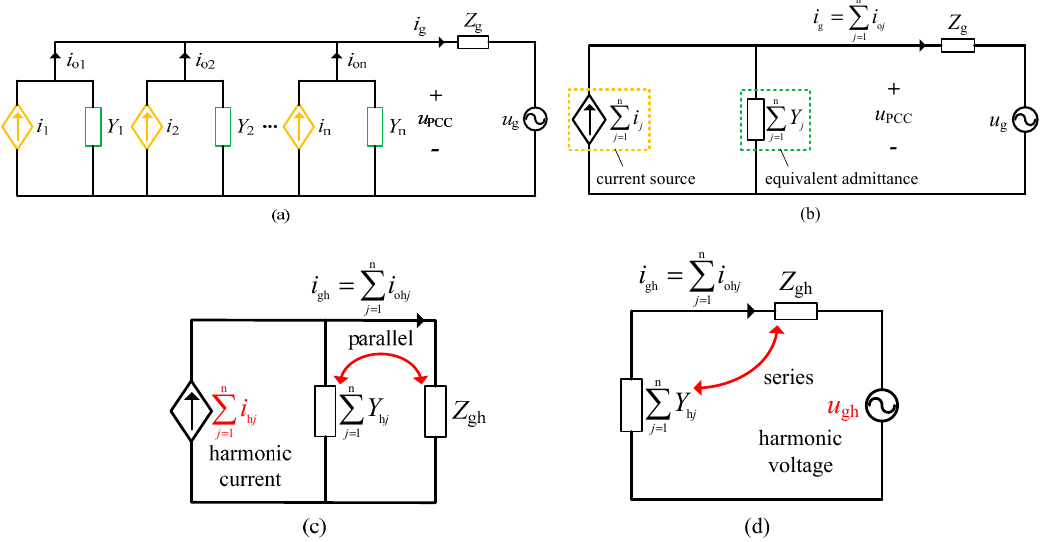
Figure 2. Output admittance model and oscillation mechanism of paralleled multi-inverter system. ( a ) Norton equivalent circuit; ( b ) Output admittance model; ( c ) Parallel oscillation; ( d ) Series oscillation.